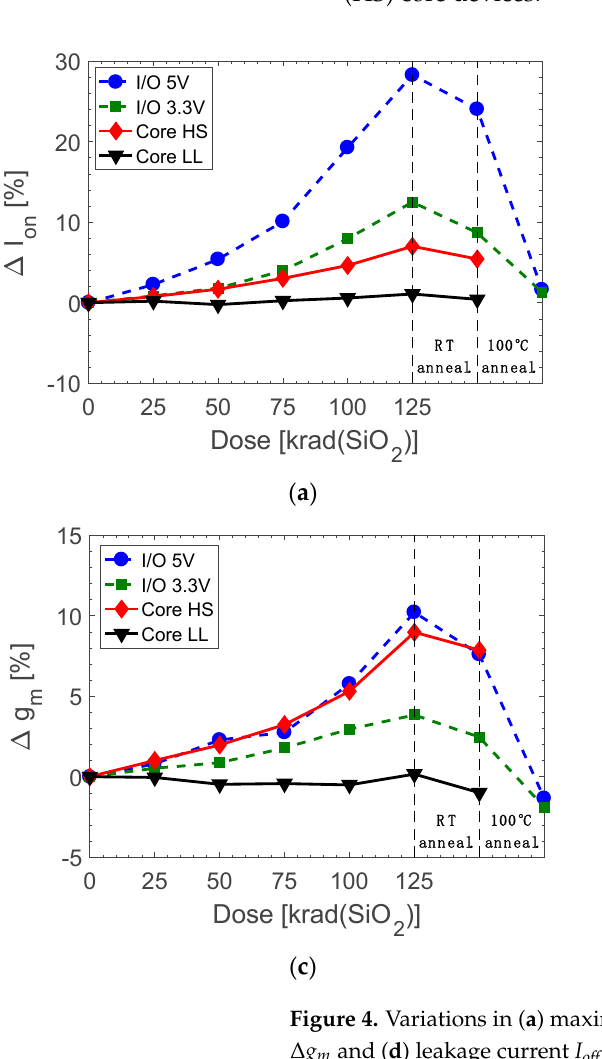
- Low-leakage (LL) core devices show a higher TID tolerance than that of high-speed (HS) core devices.